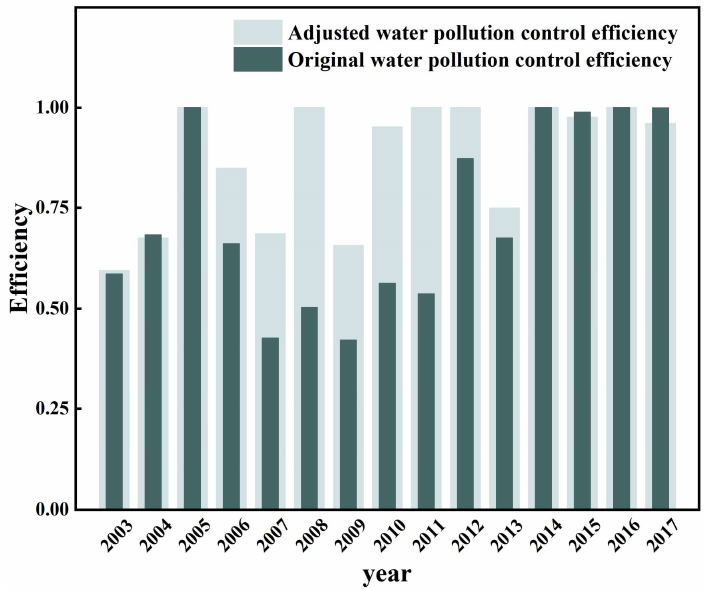
Figure 8. Comparison of the original and adjusted efficiency of water pollution control.